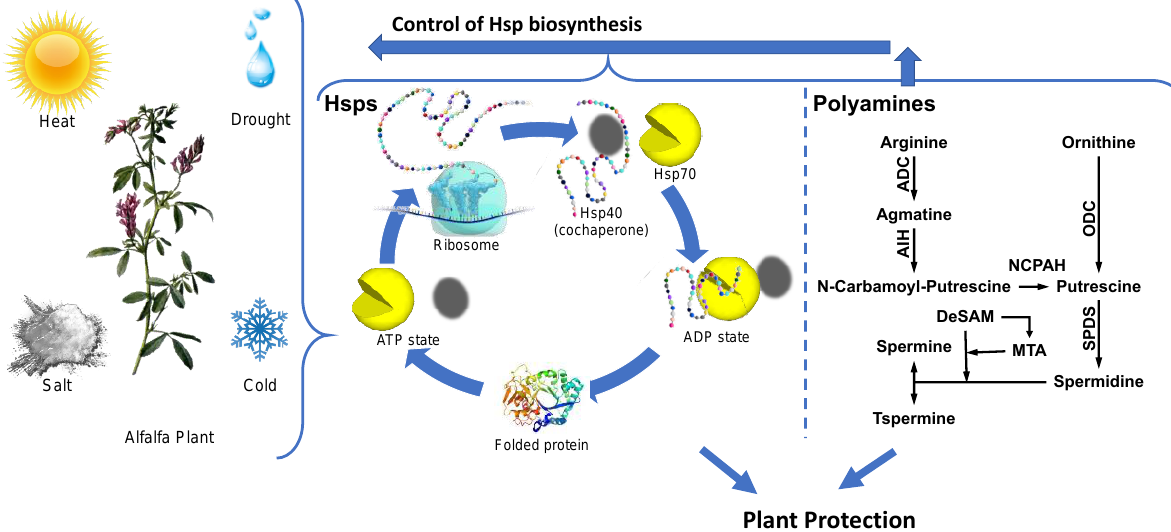
Figure 2. Benefits of heat shock proteins and polyamines in crop production. External conditions such as heat, drought, salt and cold, activate the expression of Hsps and synthesis of PAs as protective factors under stressful conditions. The folding process of proteins is driven by the ATP/ADP cycle of heat shock protein 70 (Hsp70) in cooperation with the Hsp40 co-chaperone. Biosynthesis of PAs promotes cell differentiation, proliferation, and cell growth. An undefined, molecular mechanism, triggered by PAs, leads to a control of Hsp biosynthesis and results in plant protection. Abbreviations: ADC, S-Adenosylmethionine decarboxylase, ODC, ornithine decarboxylase, AIH, agmatine iminohydrolase, NCPAH, N-carbamoylputrescine amidase, DeSAM, decarboxylated SAM, MTA, 5′ -methyl-thioadenosine, SPDS, Spermidine synthase.